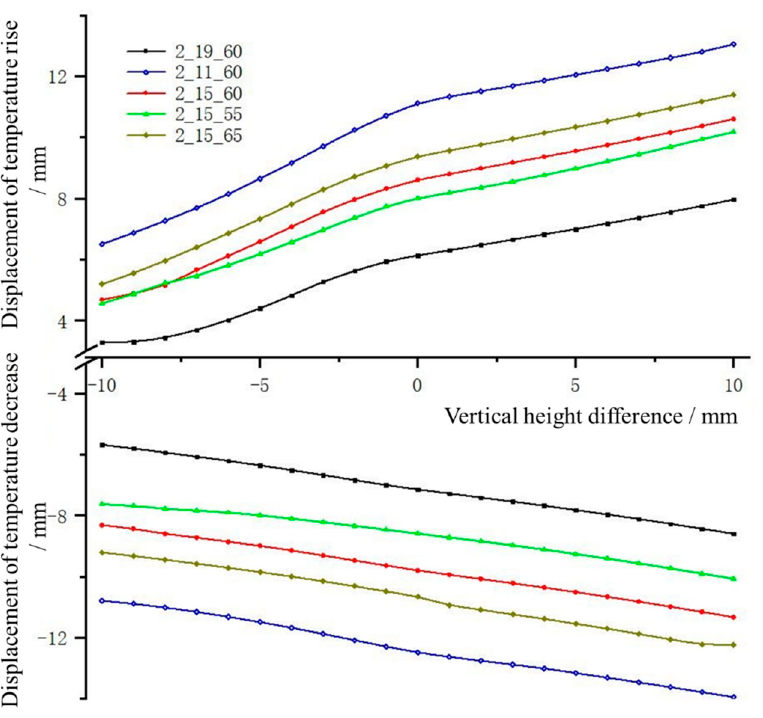
Figure 10. Temperature variation displacement curve.